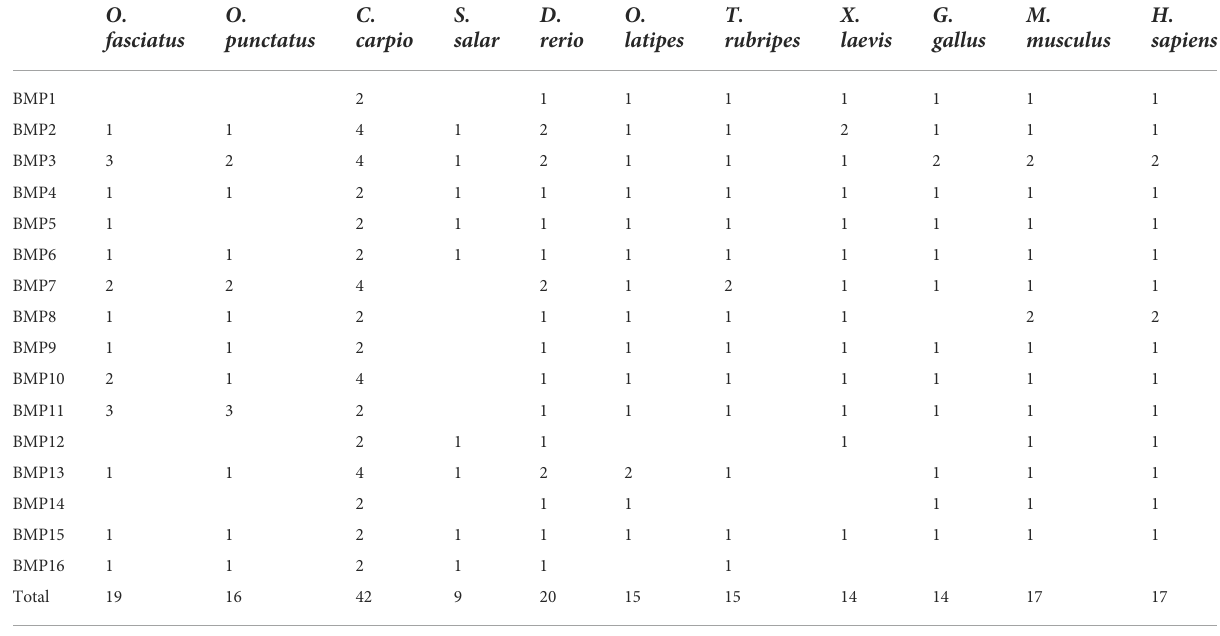
TABLE 2 Comparison of copy numbers of BMP genes among selected vertebrate genomes.